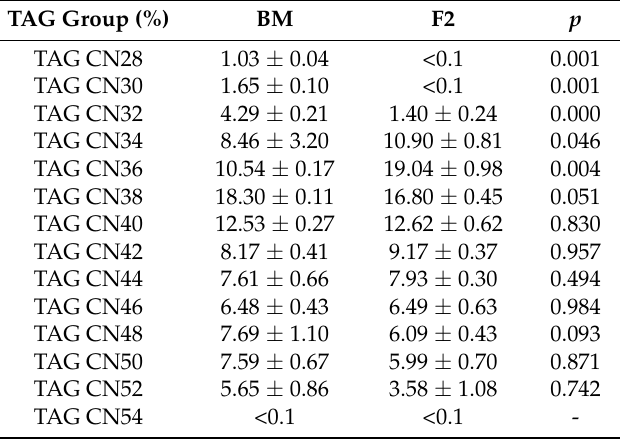
Table 2. Mean values of triacylglycerol (TAG) content according to carbon number (CN) of buttermilk (BM) and isolated lipid fraction F2 determined by